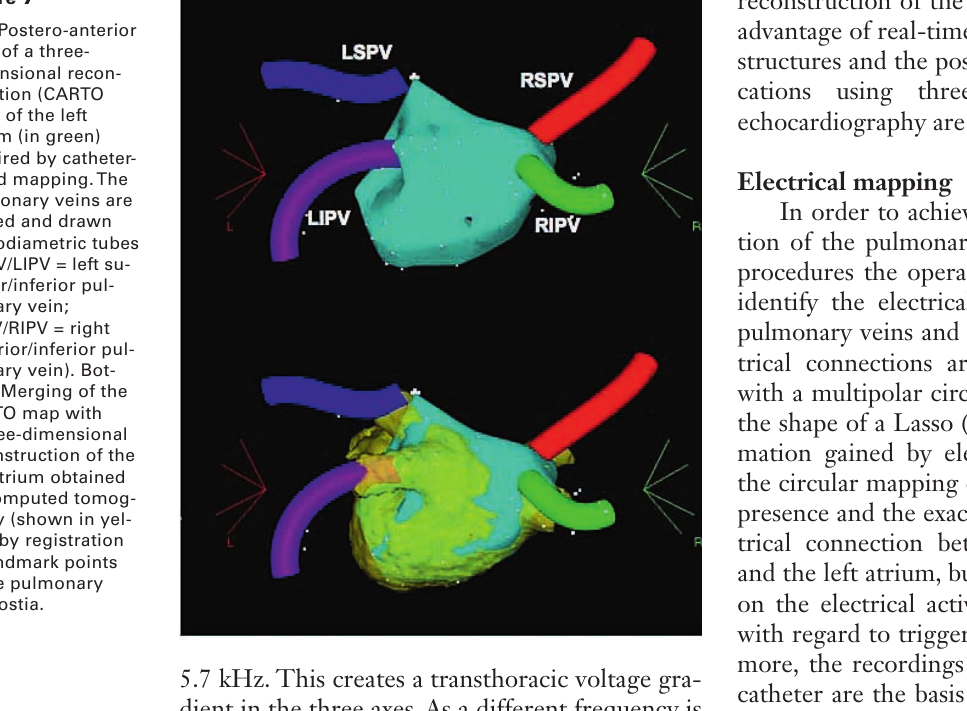
Top: Postero-anterior view of a three- dimensional recon- struction (CARTO map) of the left atrium (in green) acquired by catheter- based mapping.The pulmonary veins are tagged and drawn as isodiametric tubes (LSPV/LIPV = left su- perior/inferior pul- monary vein; RSPV/RIPV = right superior/inferior pul- monary vein). Bot- tom: Merging of the CARTO map with a three-dimensional reconstruction of the left atrium obtained by computed tomog- raphy (shown in yel- low) by registration of landmark points at the pulmonary vein